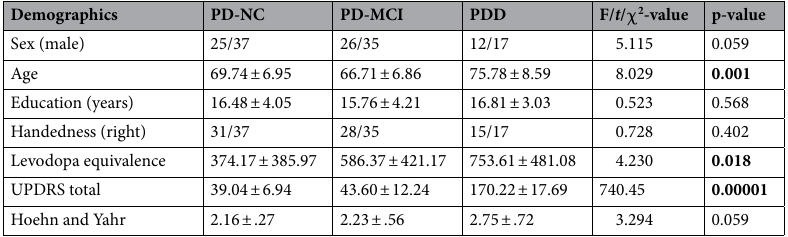
Table 1. Participant demographics and clinical features. Values are given as fractions, or means ± SD. The levodopa equivalence standard deviation is high in our cohort, indicating that participants used a broad range of dosages. “UPDRS” = Unified Parkinson’s Disease Rating Scale. The p-values in bold indicate those differences between the populations that are statistically significant at a 0.05 level of